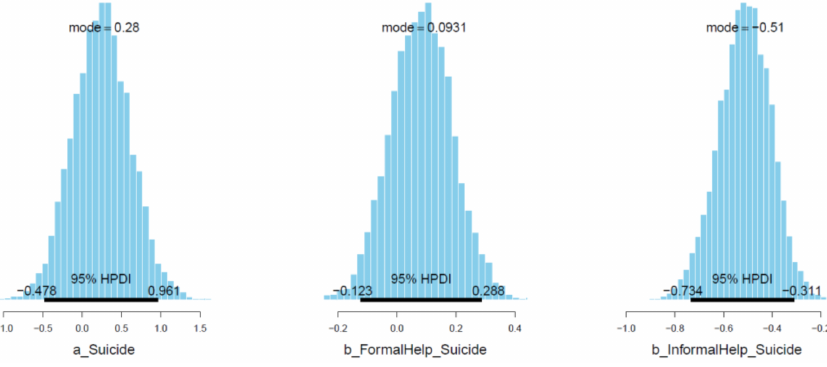
Figure 19. Distributions of Model 4 (cid:48) s posterior coefficients with HPDI at